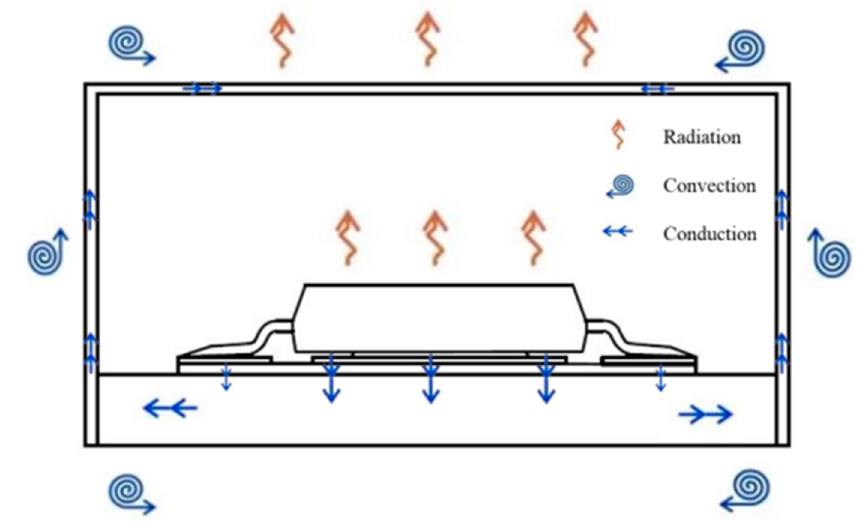
Figure 2. LED enclosed compact space schematic.